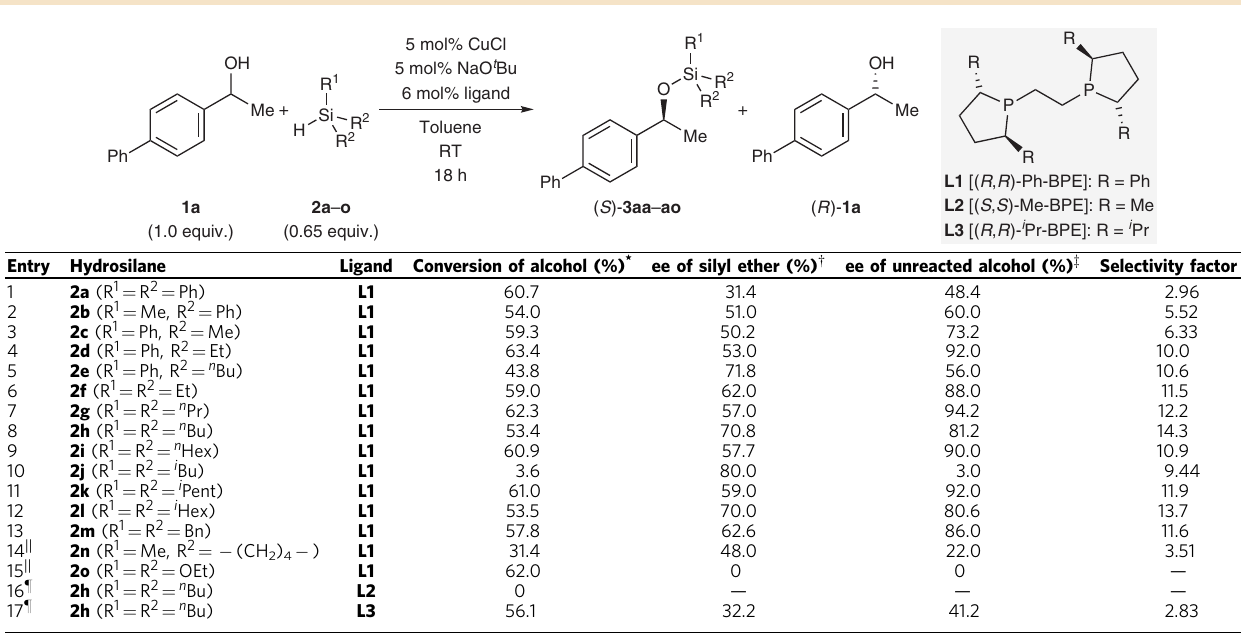
Table 1 | Optimization of hydrosilane and ligand structures in the catalytic asymmetric Si-O